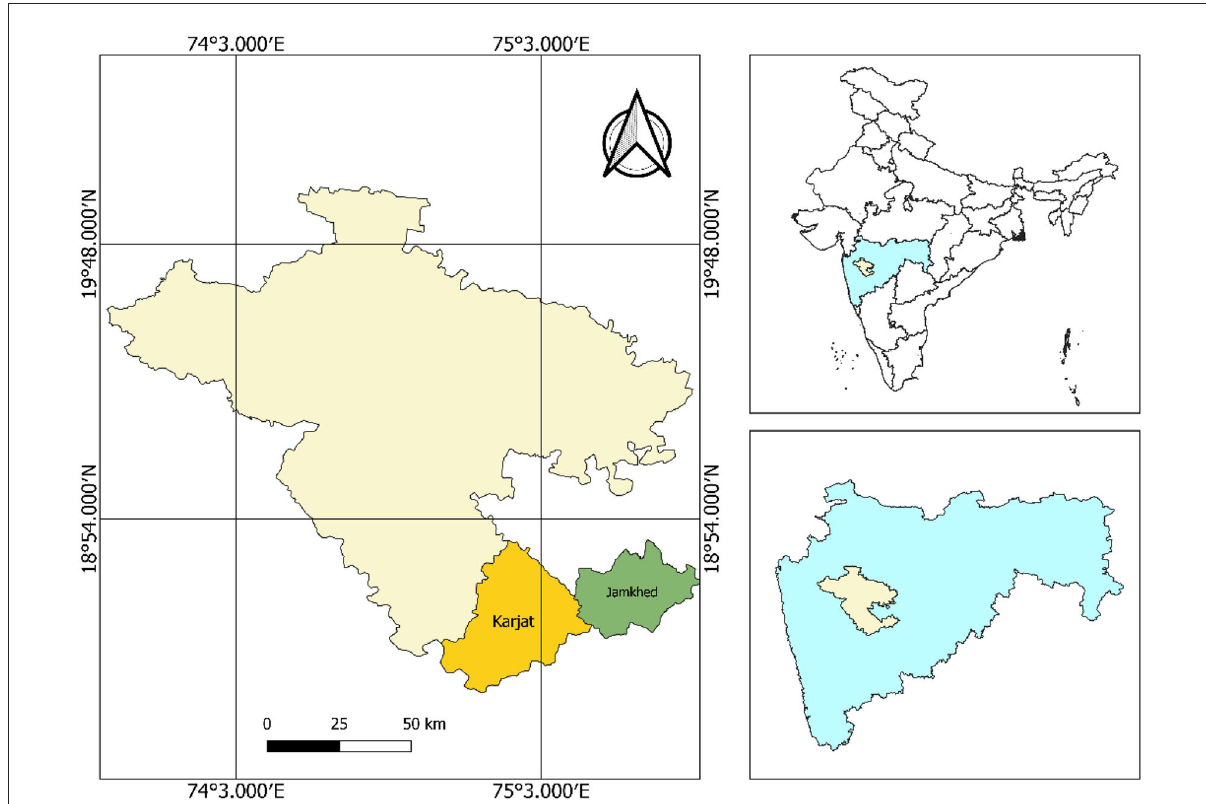
FIGURE4 Jamkhed (green) and Karjat (orange) talukas in Ahmednagar (orange) district of Maharashtra state (sky